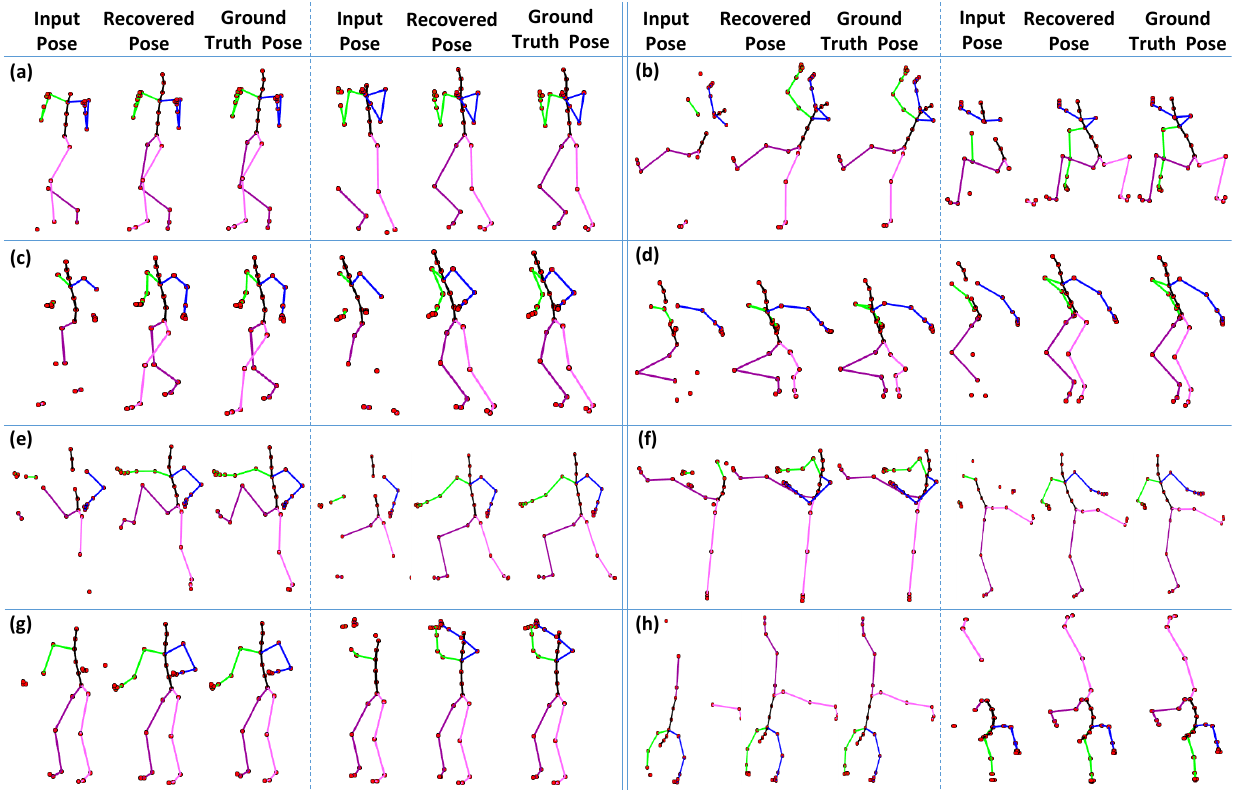
Figure 16. The 3D recovery results for different motion categories, when the number of missing joints is m = 6. ( a ) Boxing; ( b ) Jumptwist; ( c ) Run fig8; ( d ) Jumping; ( e ) Martial Arts; ( f ) Kicking; ( g ) Salsa; ( h )